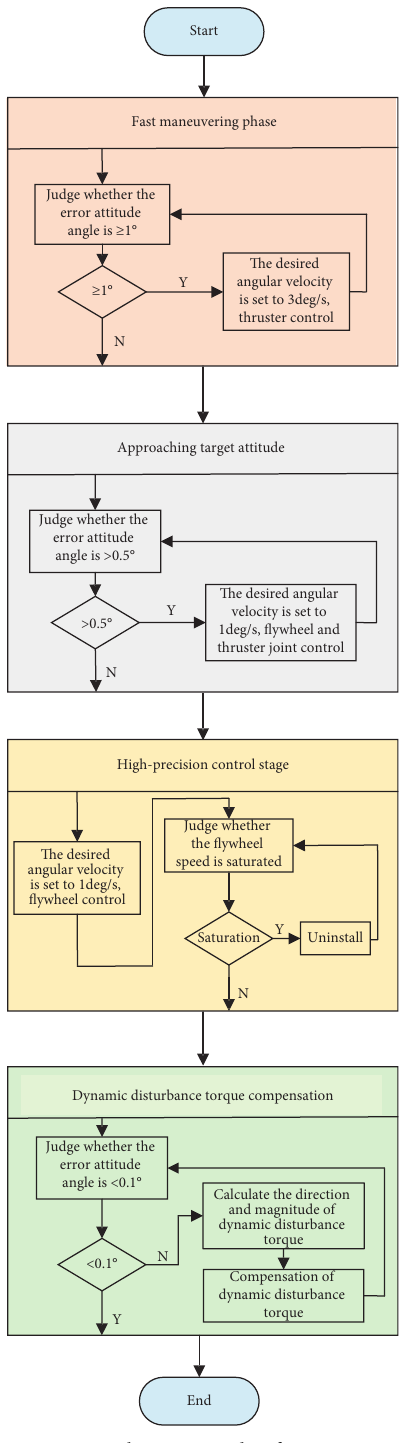
Figure 5: Working principle of joint